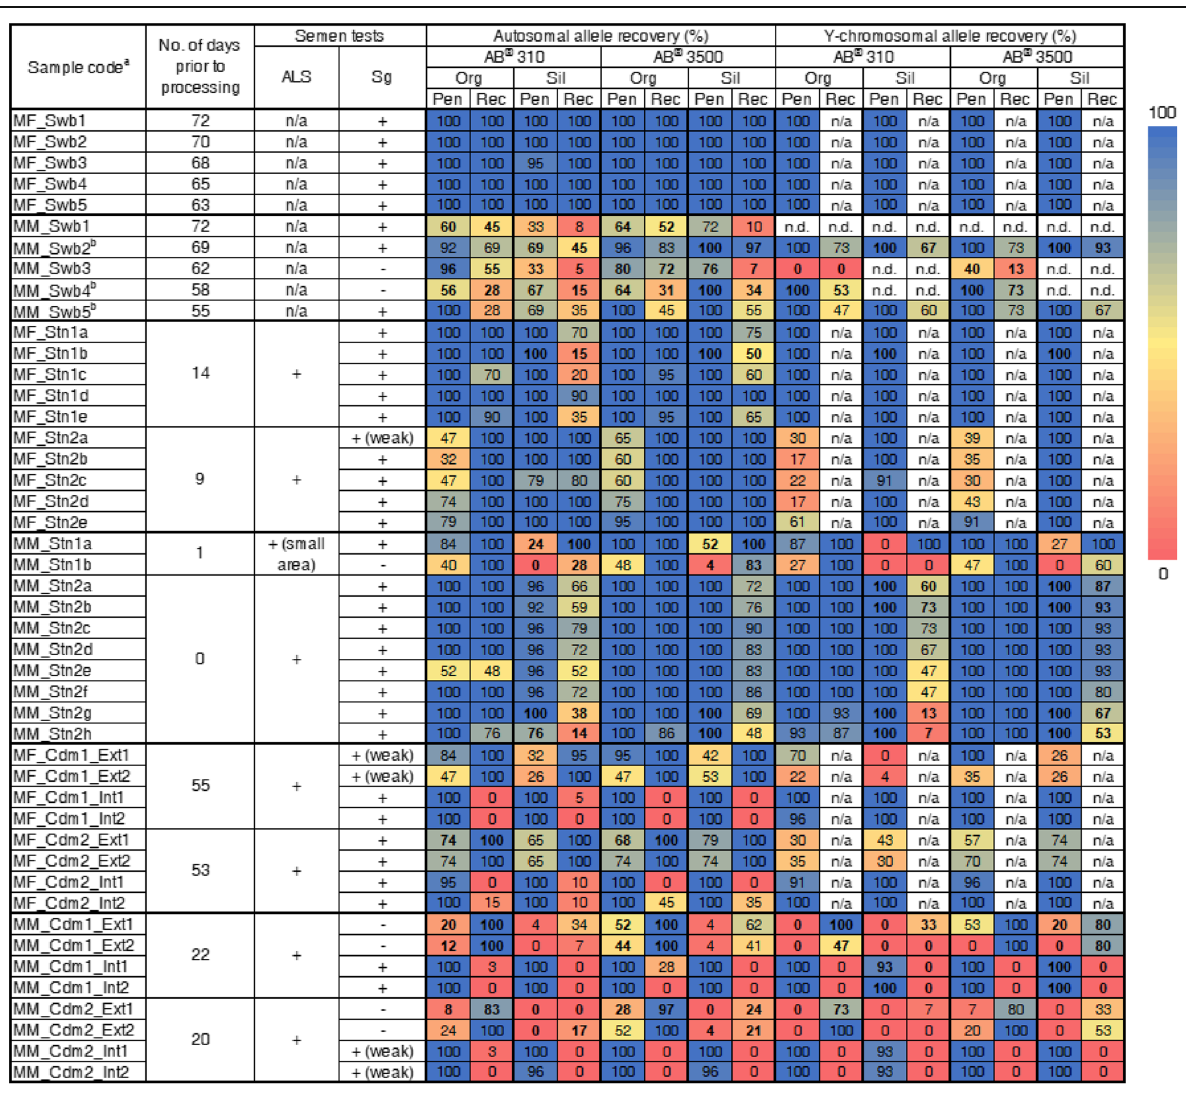
Fig. 2 Semen detection and recovery of unshared alleles among contributor components in post-coital samples. Superscript a indicates MF, male-female; MM, male-male; Swb, swab; Stn, stain; Cdm, condom; Ext, external swab; Int. internal swab. Superscript b indicates with visible mold growth. Org, organic extraction; Sil, silica-based extraction; Pen, penetrative partner; Rec, receptive partner; n/a, not applicable; and n.d, not done (the DNA extract was deficient in amount such that not enough template was left for Y-chromosomal typing). Values in boldface indicate samples amplified in full volume (25 μ L) reaction to accommodate 5-ng DNA template mass. The rest were amplified in reduced volume (10 μ